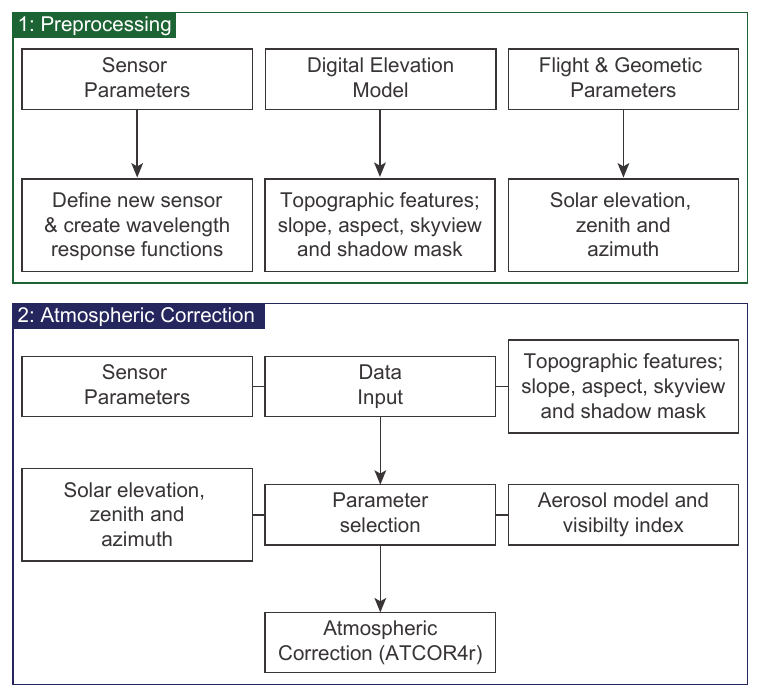
Figure 5. Overview of the major processing phases of